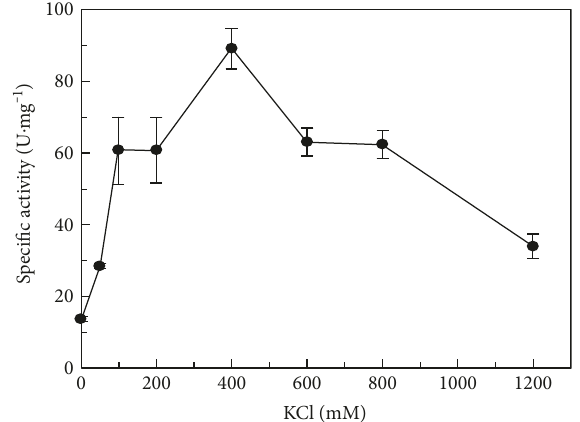
Figure 2: E ff ect of KCl concentration on the speci fi c activity of ComC in the reduction reaction. Other assay conditions were standard; 37 ° C and pH 6.5. Assays were carried out in triplicate. One unit of activity (U) is de fi ned as the conversion of one μ mol of NADH to NAD + per minute under standard assay